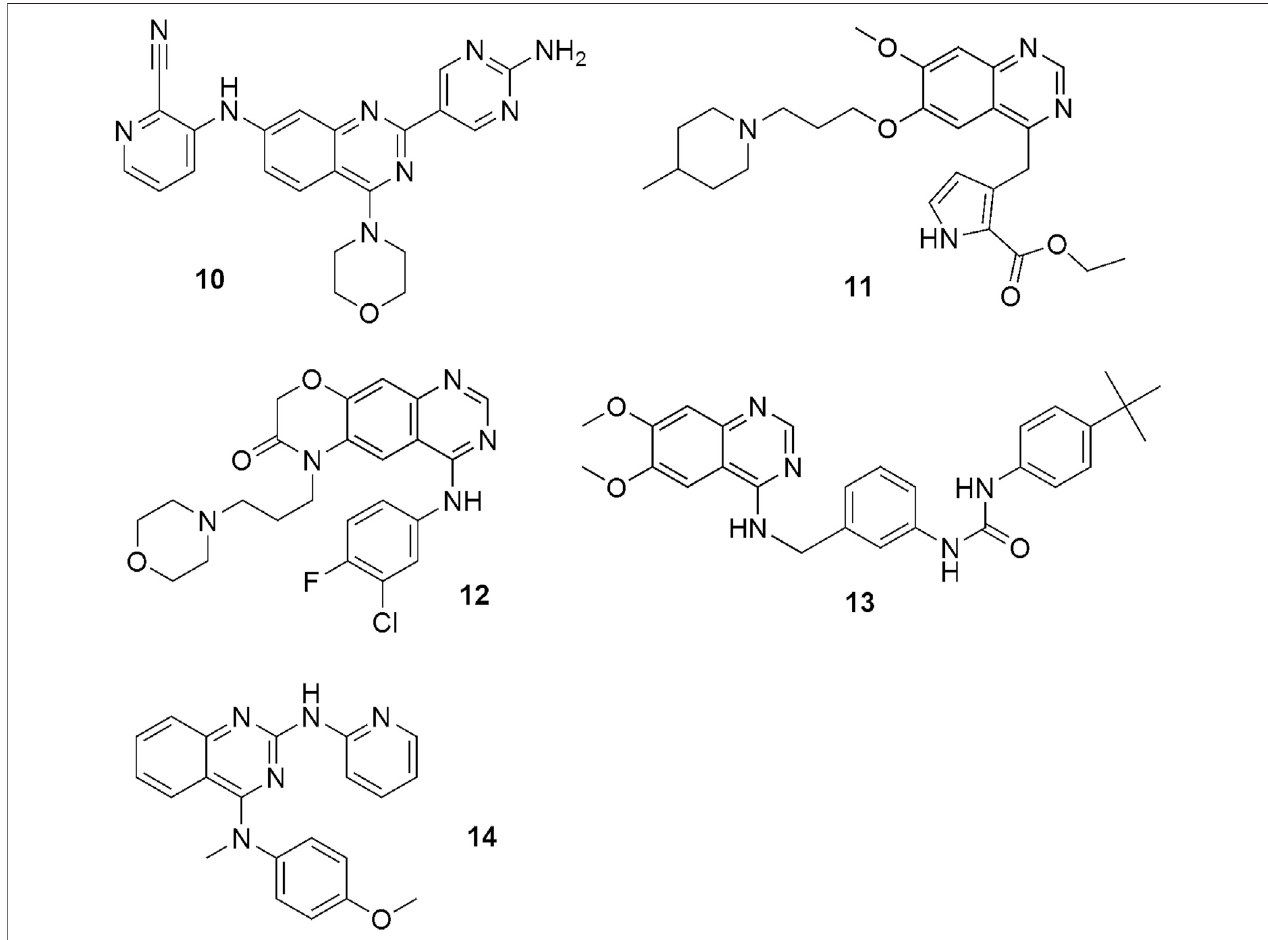
FIGURE 2 | Structures of some compounds of antitumor potency incorporating quinazolinone frameworks.